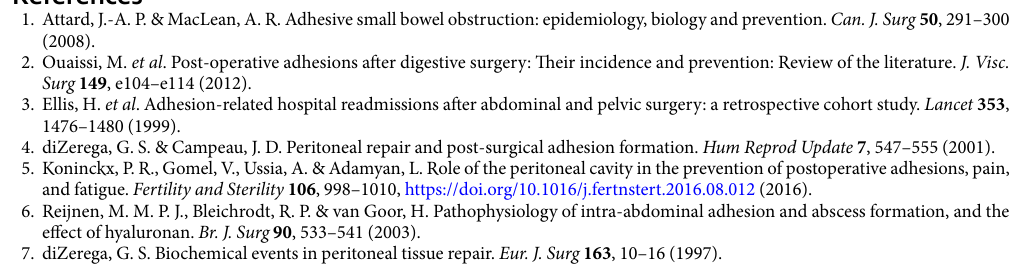
10 SCIENTIfIC RepoRTS | (2018) 8:9481 | DOI:10.1038/s41598-018-25994-5